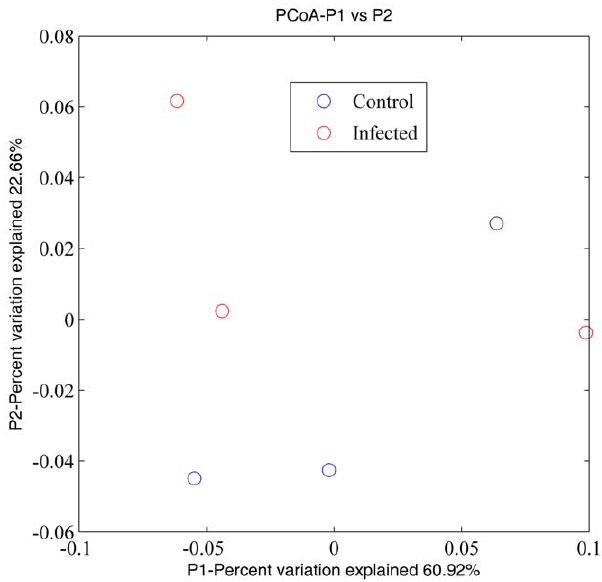
Figure 6. Principal Coordinates Analysis (PCoA) of weighted UniFrac values between control (blue) and infected (red) animals ( N =3): visualization of the first two dimensions (scaled).